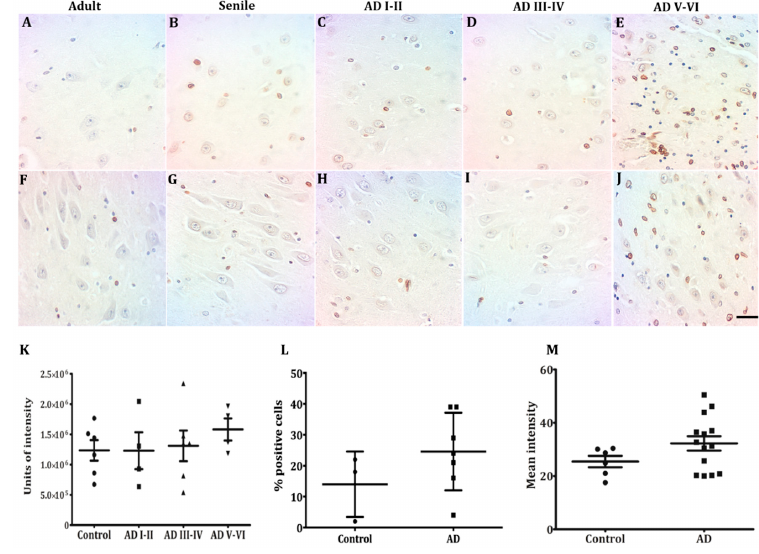
Figure 5. Lamin B1 in pyramidal hippocampal neurons. Low-intensity Lamin B1 immunopositivity is present at all conditions studied ( A – J ), with slightly higher levels at AD V-VI ( E – J ), oligodendrocytes and microglia intensely stained ( E , J ). Lamin B1 did not present quantitative changes across the di ff erent conditions ( K - M ). Each point represents the image analysis of 50 cells per subject in CA1 and CA3 regions. Graphs express mean ± SD, * p < 0.05. See the text for further details of image analysis and